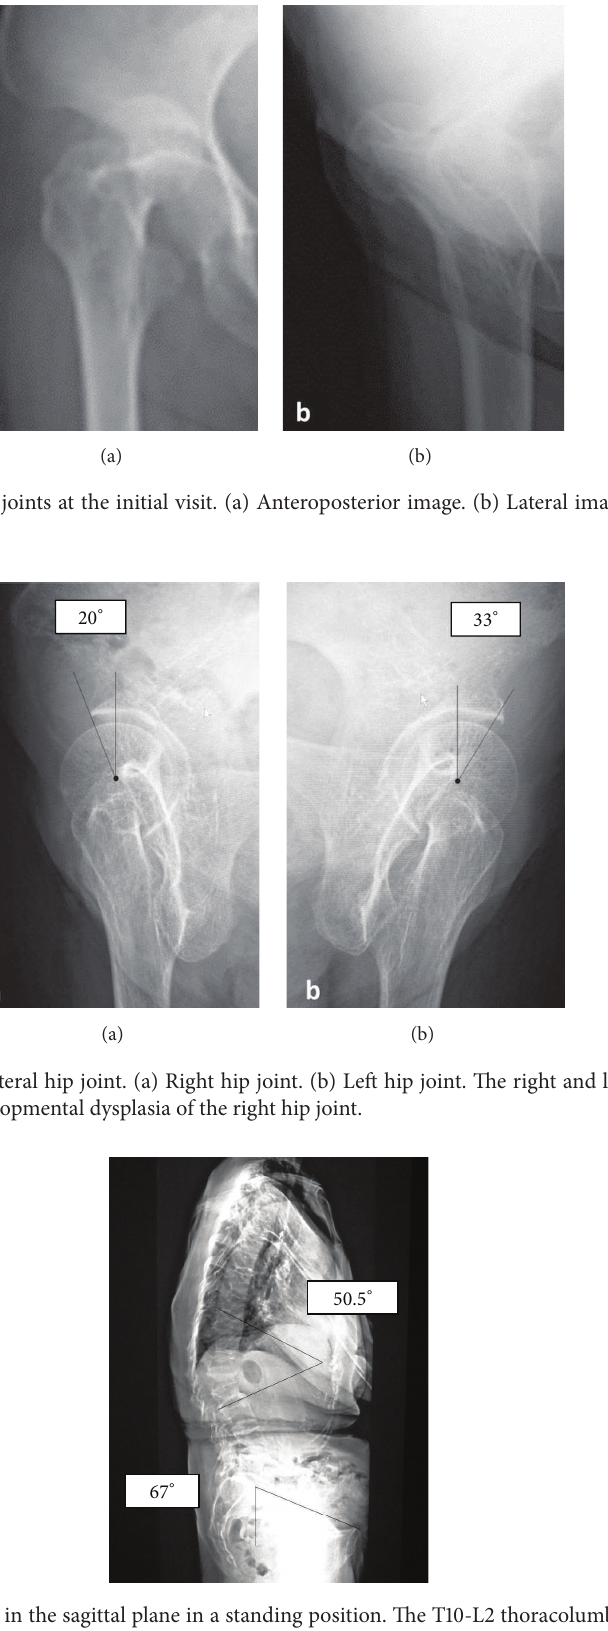
Figure 3: Slot radiography of the spine in the sagittal plane in a standing position. The T10-L2 thoracolumbar angle is 50.5 ∘ . Sagittal pelvic tilt angle is 67 ∘ . This image reveals severe posterior pelvic tilt following thoracolumbar kyphosis due to vertebral